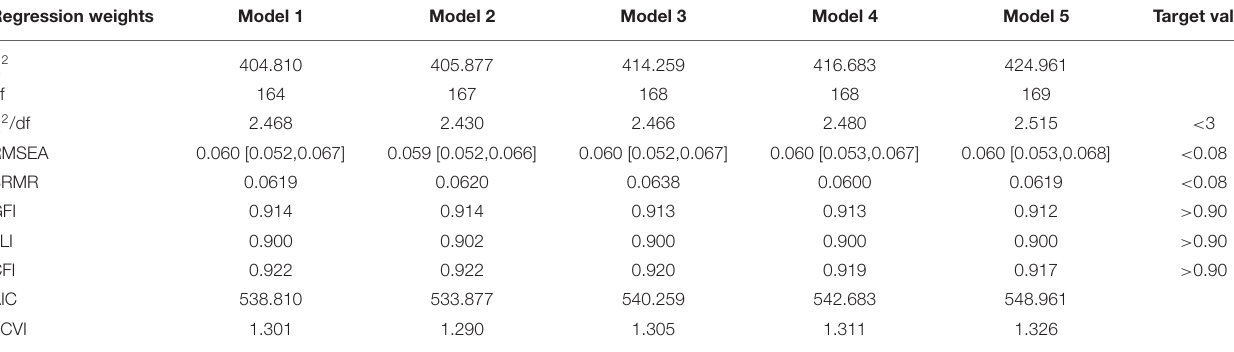
TABLE 3 | Fit indices among competing models after controlling gender and age. Regression